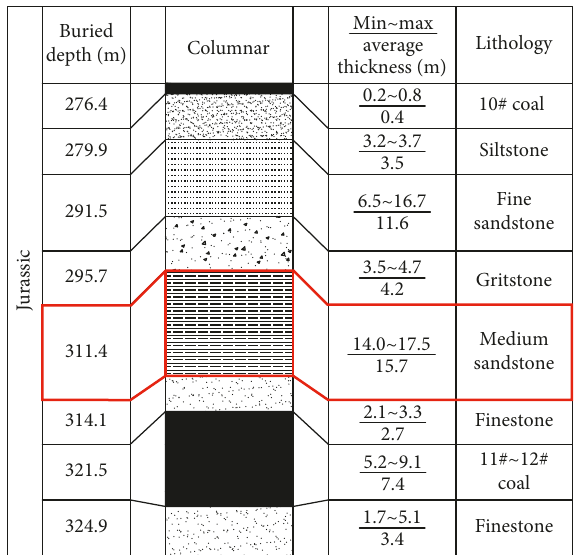
Figure 19: Local stratigraphic